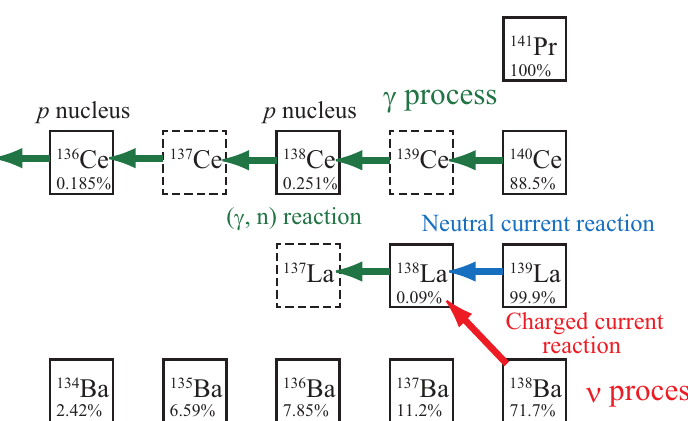
Figure 4. Partial nuclear chart and nucleosynthesis flows around Ce, La, and Ba. 138 La is a ν isotope which is produced predominantly by the charged current reaction and neutral current reaction in the ν process, whereas 138 La is also destroyed by the ( γ , n) reaction. 136 Ce and 138 Ce are p nuclei which are predominantly produced by the successive ( γ , n) reactions from heavy isotopes such as 140